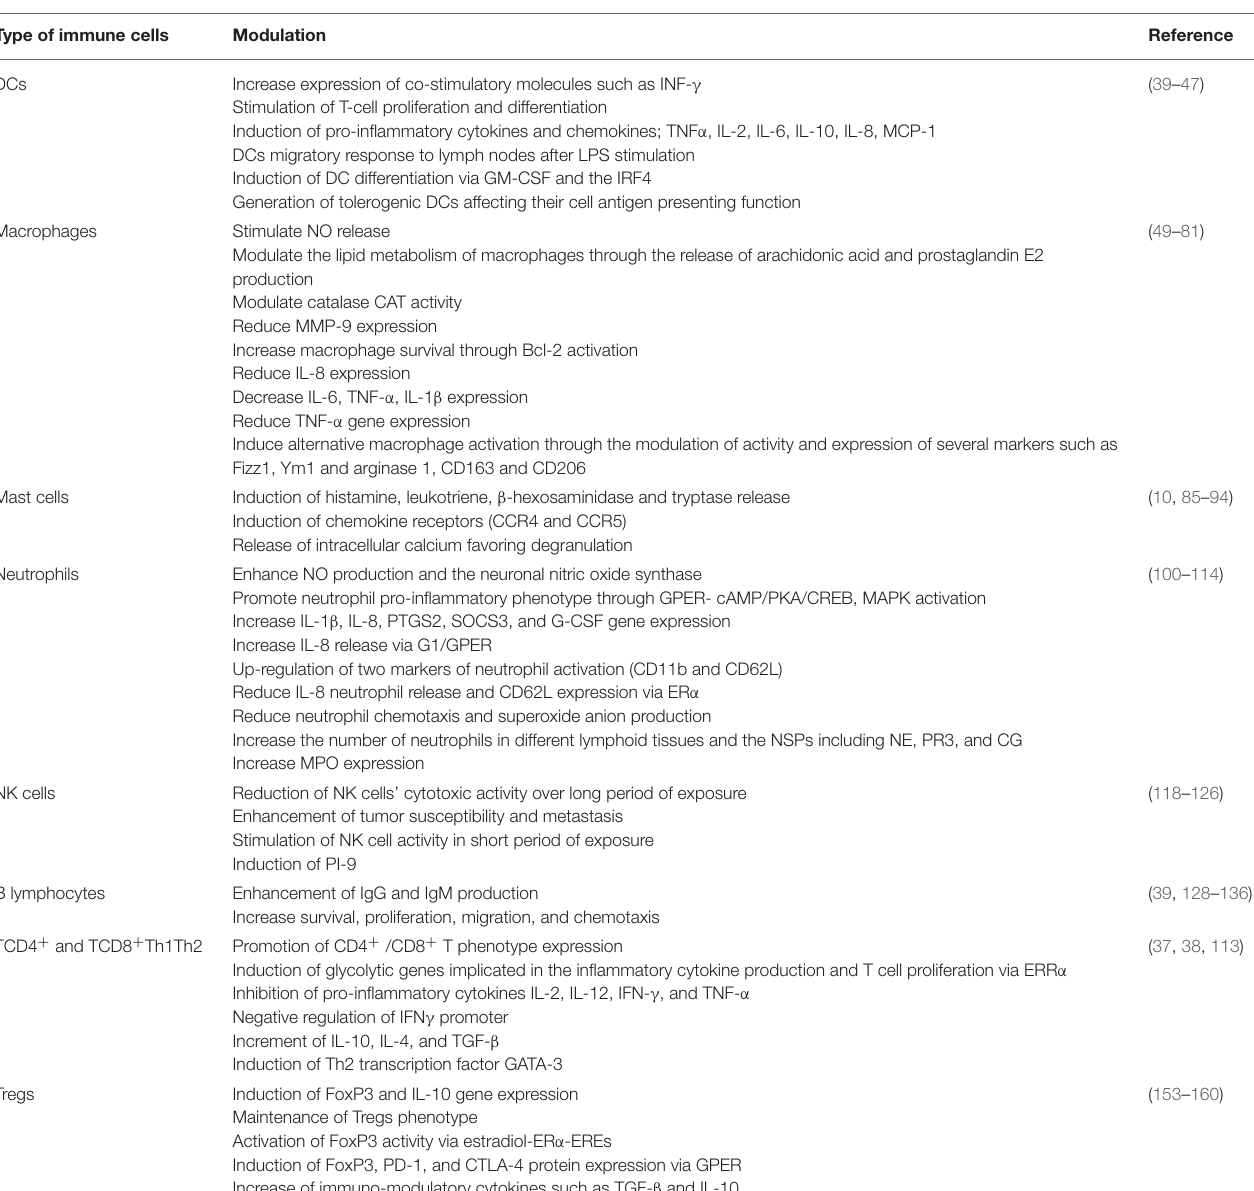
TABLE 1 | Estradiol effects of different immune